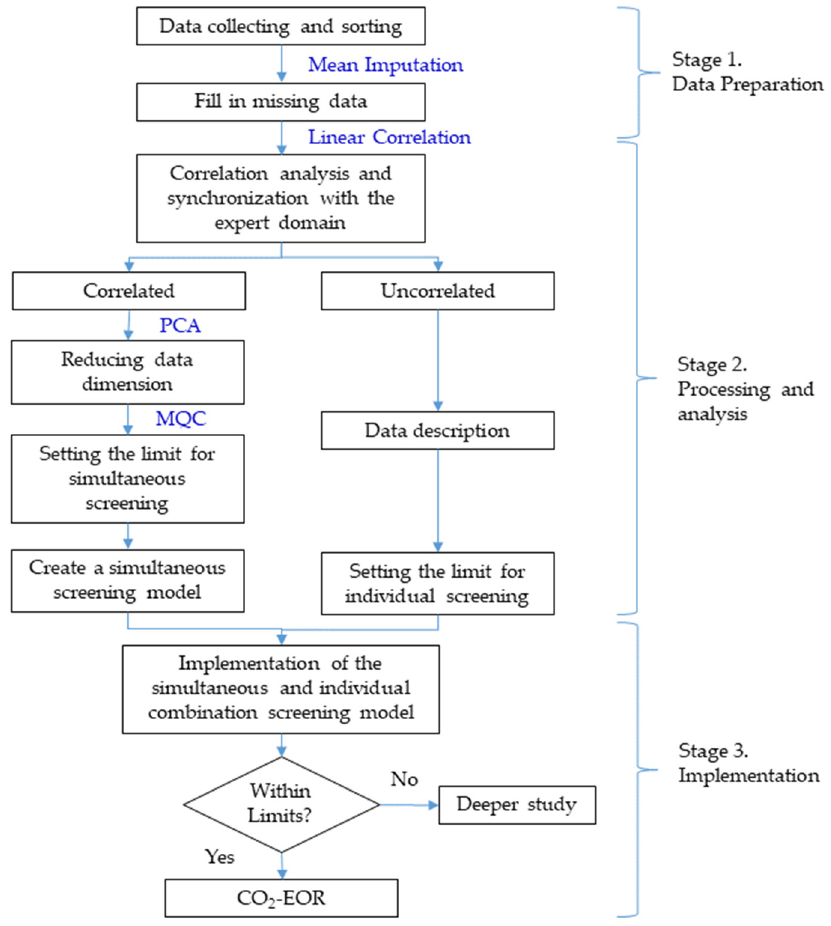
Figure 1. CO 2 -EOR screening model workflow.